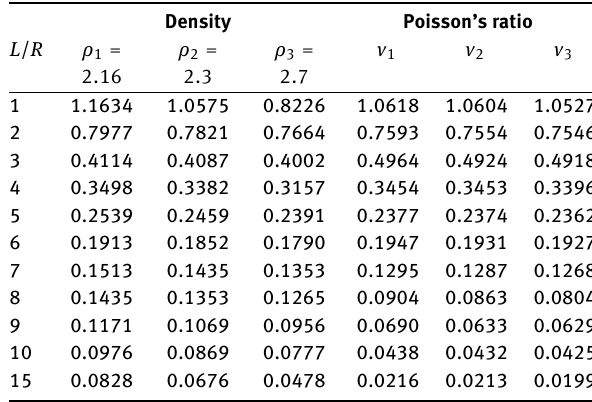
Table 3: Nonlocal constant and Pasternak foundation effects on